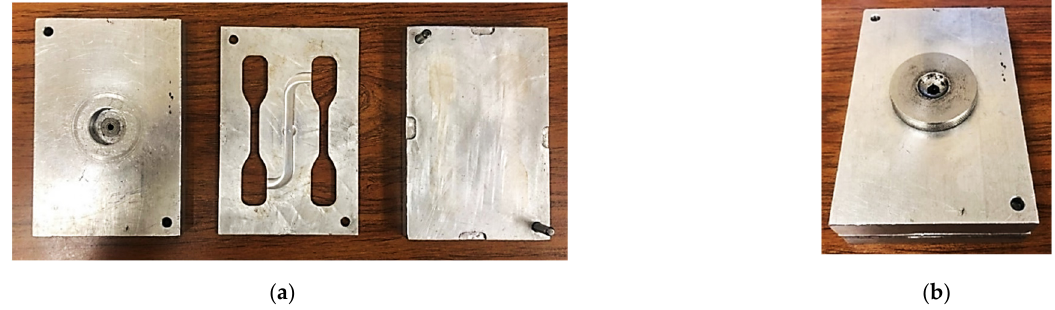
Figure 1. Three-piece injection mold designed for lignin blends: ( a ) showing the three separate pieces; ( b ) assembled mold with the sprue.